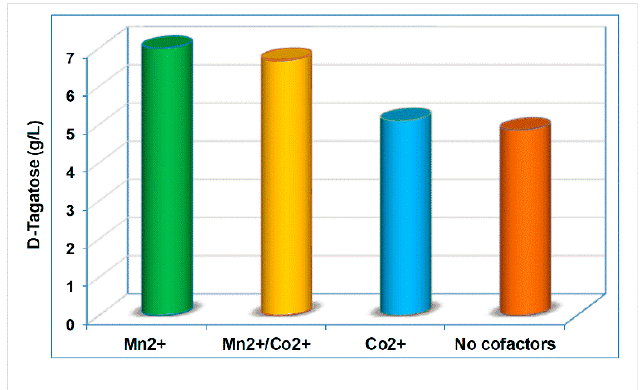
Figure 4. E ff ect of metal ions on the activity of L-arabinose isomerase US100 from B. stearothermophilus , Figure 4. Effect of metal ions on the activity of L -arabinose isomerase US100 from B. stearothermophilus , in absence or presence of 0.5 mM MnSO 4 and / or 0.1 mM CoCl 2 . Experimental conditions: 20 g / L in absence or presence of 0.5 mM MnSO 4 and/or 0.1 mM CoCl 2 . Experimental conditions: 20 g/L D - D-galactose, 100 mM MOPS (pH 7.5), 0.65 U / mL L-AI, 65 ◦ C. The concentration of D-tagatose was galactose, 100 mM MOPS (pH 7.5), 0.65 U/mL L-AI, 65 °C. The concentration of D -tagatose was measured after 4 h by HPAEC-PAD. measured after 4 h by HPAEC-PAD.